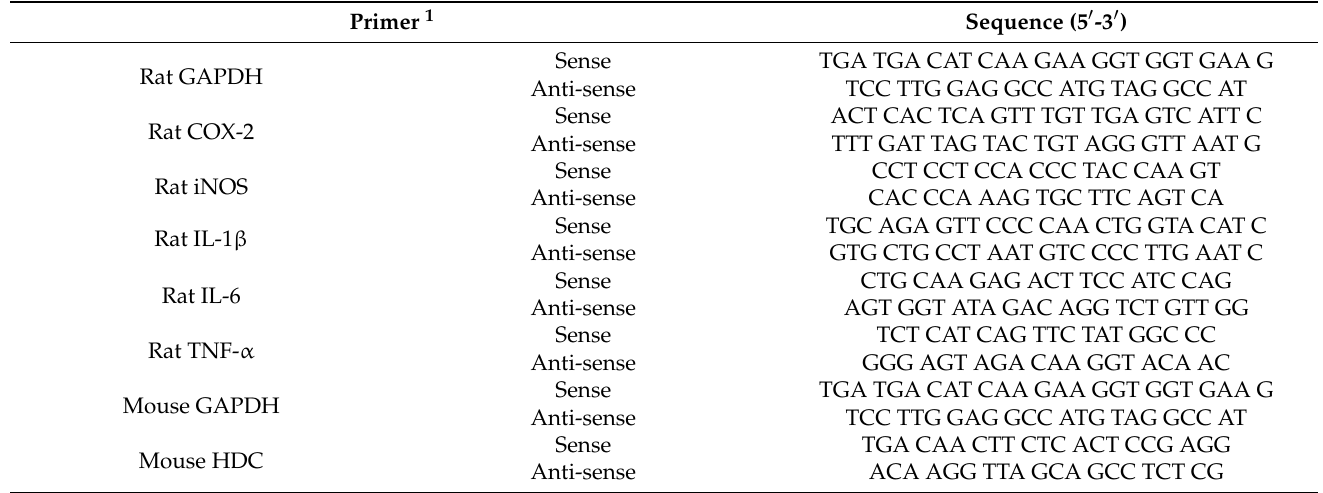
Table 1. List of primers for